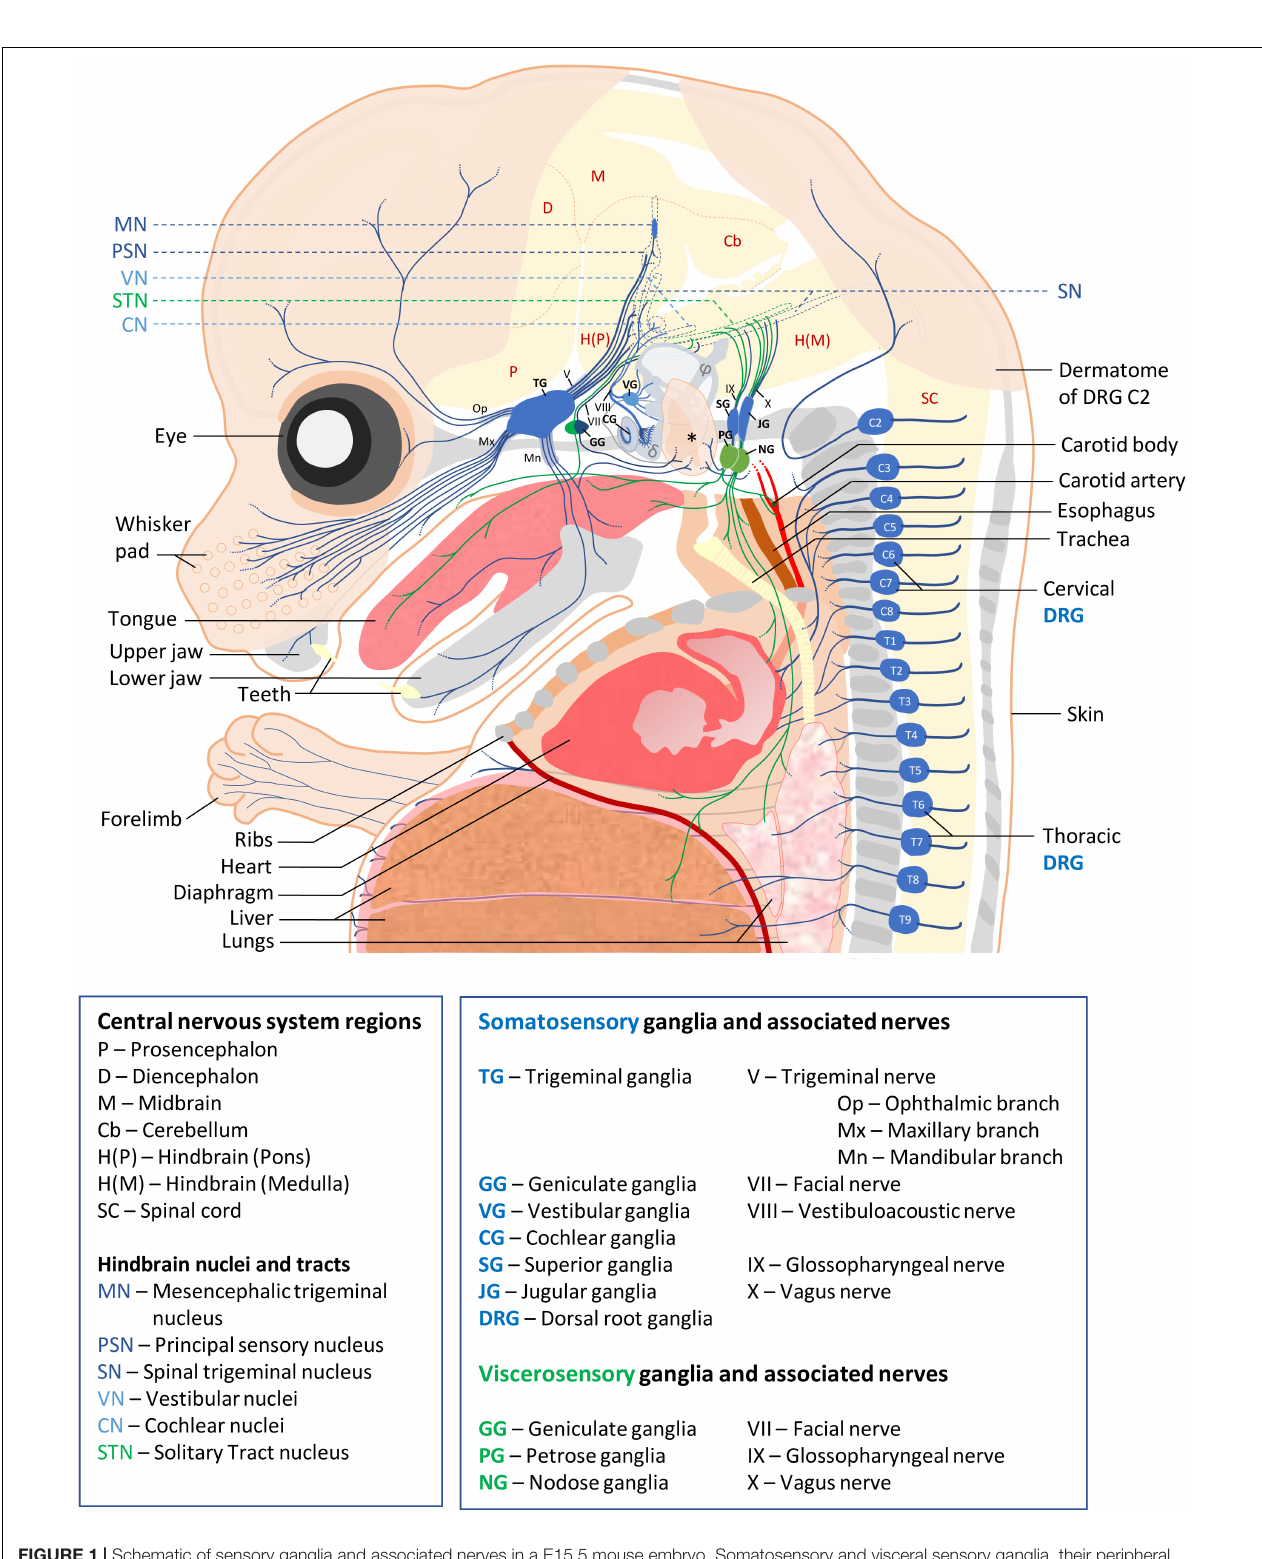
FIGURE 1 | Schematic of sensory ganglia and associated nerves in a E15.5 mouse embryo. Somatosensory and visceral sensory ganglia, their peripheral innervation and targets in the CNS are represented in blue and green, respectively. The different organs and tissues are indicated. Bones are shown in gray. The external ear is indicated by an asterisk, semi-circular ducts by ϕ and cochlea by a δ symbol. For clarity, the olfactory epithelium, the accessory ganglia and (para-)sympathetic ganglia, the enteric nervous system and the motor efferents of cranial and spinal nerves have not been represented. Abbreviations used for all ganglia, nerves and CNS regions are indicated below the